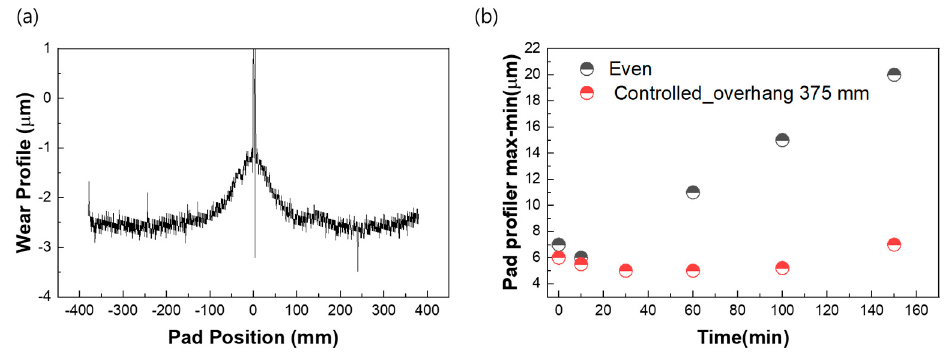
Figure 12. ( a ) Pad wear profile under a controlled condition with a 375 mm overhang, ( b ) Pad thickness variation over time under even and controlled conditions with an overhang of 375 mm.